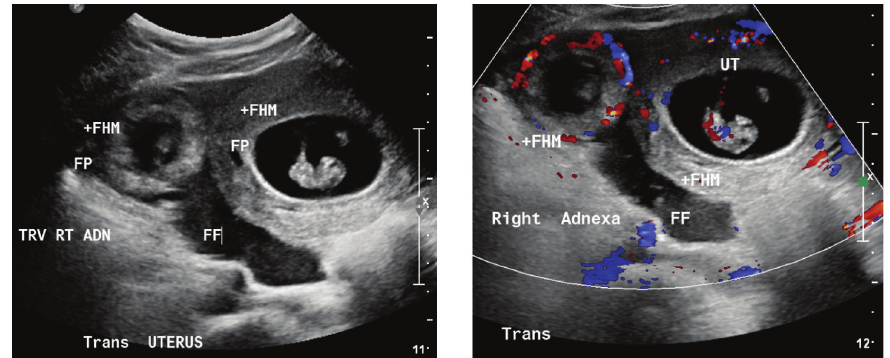
Figure 1: Patient number 1. Pelvic ultrasound showing the intrauterine and extrauterine/tubal ectopic pregnancies, both with fetal pole (FP), fetal heart rates (+FHM) present, and free fluid (FF) in the peritoneal cavity.